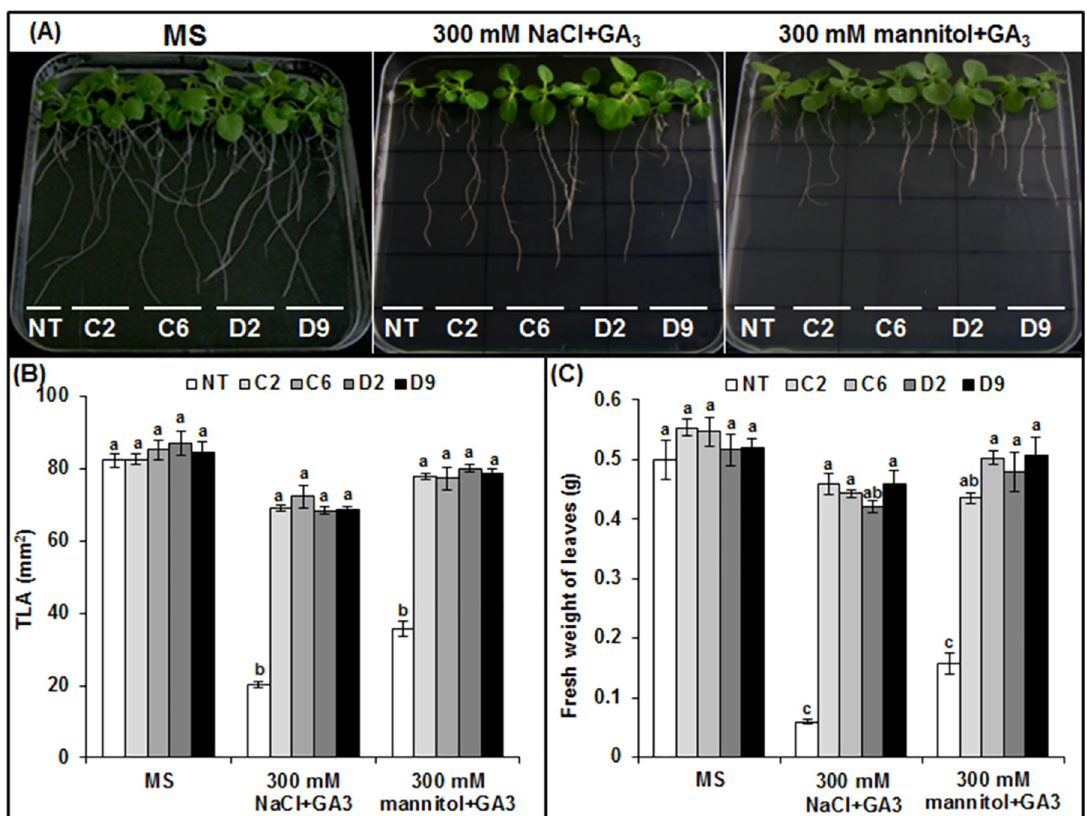
Fig 6. Response of transgenic tobacco plants overexpressing the LmSAP gene to exogenous GA 3 . ( A ) Phenotypes of non-transgenic (NT) and transgenic lines (C2, C6, D2, and D9) 2 weeks after in vitro incubation on MS medium (control), on MS medium containing 300 mM NaCl and 100 μ M GA 3, or on MS medium containing 300 mM mannitol and 100 μ M GA 3 . ( B ) Total leaf area (TLA) and ( C ) fresh weight of leaves of NT and transgenic plants (C2, C6, D2, and D9) grown on MS medium (control), MS medium containing 300 mM NaCl and 100 μ M GA 3 , or MS medium containing 300 mM mannitol and 100 μ M GA 3 . Data represent the means ± SEM. Means denoted by the same letter were not significantly different at p <